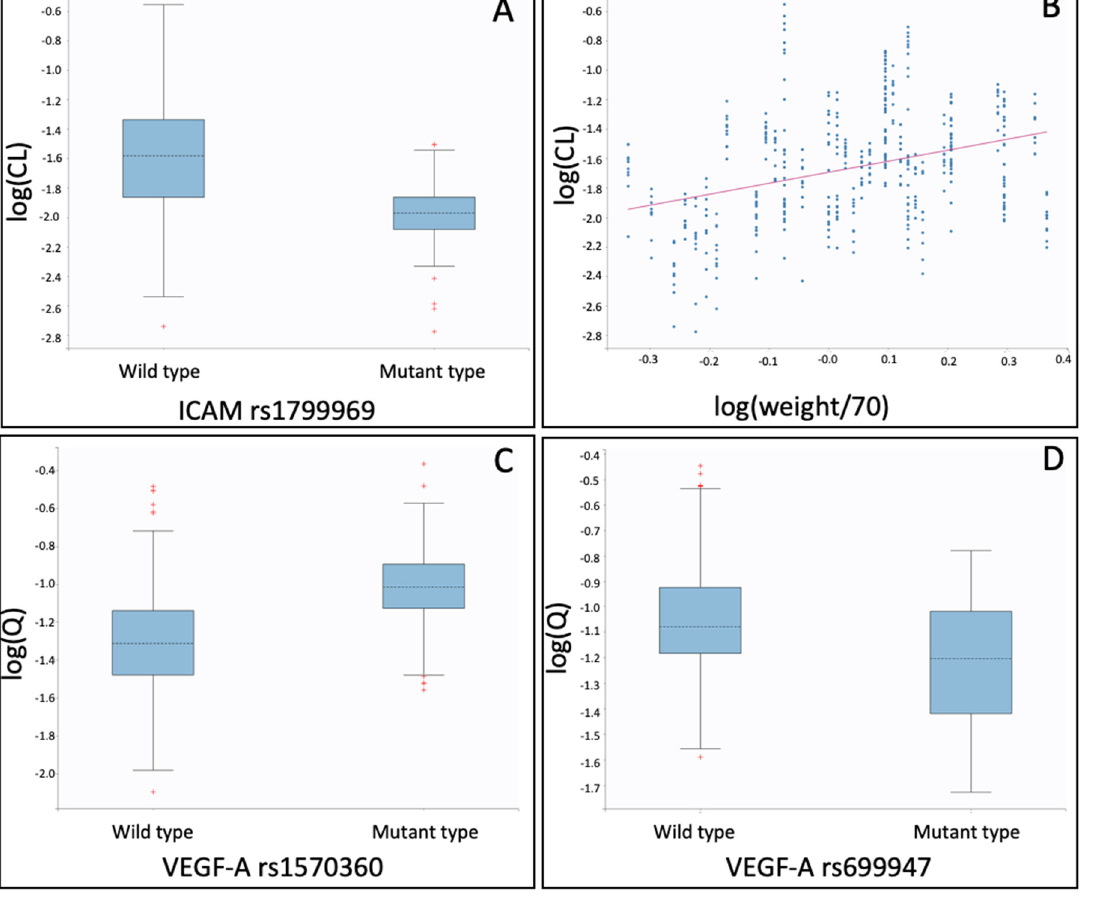
Figure 1. Individual pharmacokinetic parameter estimates of the pharmacokinetic model vs. co-variates identified: ( A ) log(CL: Clearance) vs. ICAM-1 rs1799969; ( B ) log(CL: Clearance) vs. log(weight / 70); and ( C ) log(Q: Intercompartmental clearance) vs. VEGF-A rs1570360; ( D ) log(Q: Intercompartmental clearance) vs. VEGF-A rs699947.